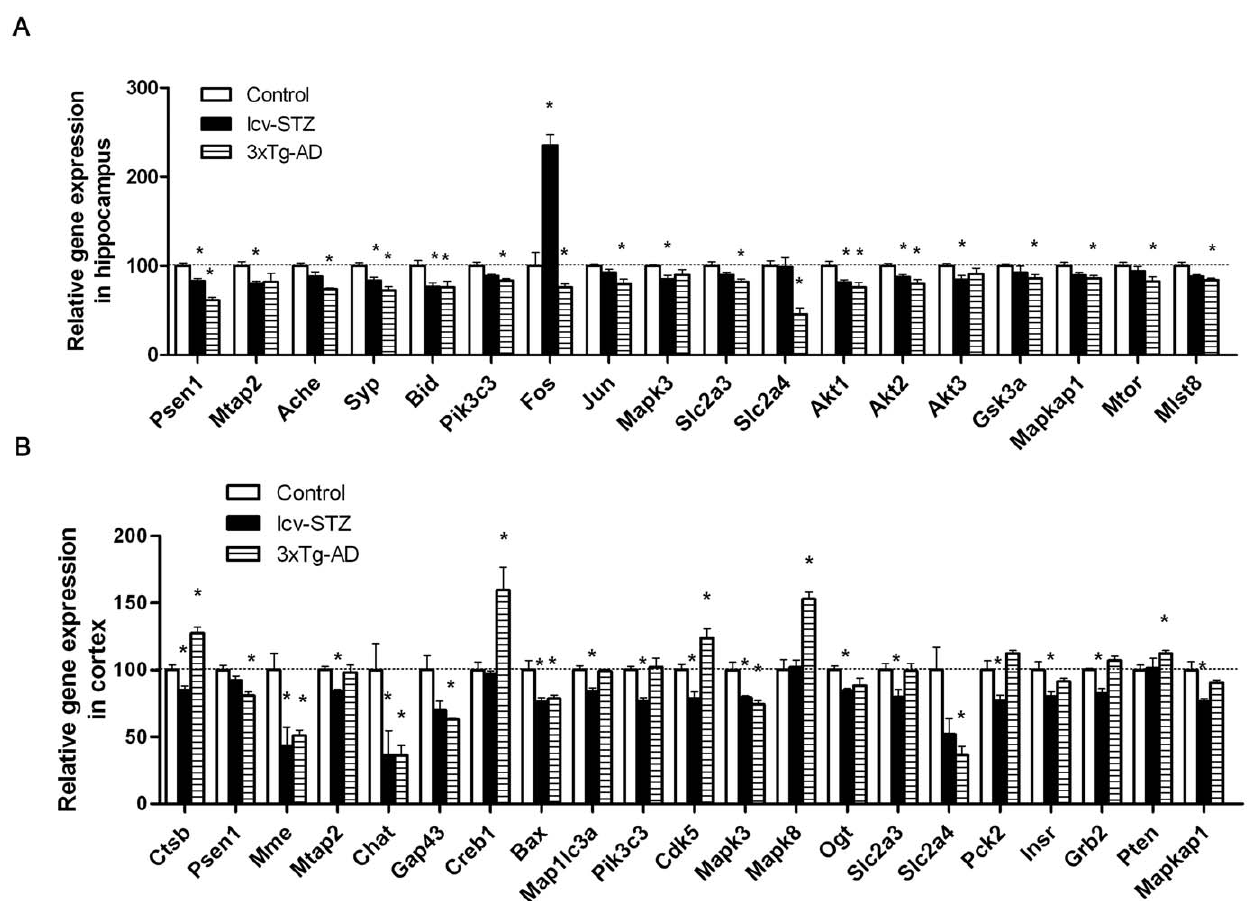
Figure 11. Comparison of altered AD-related gene expression profiles between the icv-STZ mice and the 3xTg-AD mice.